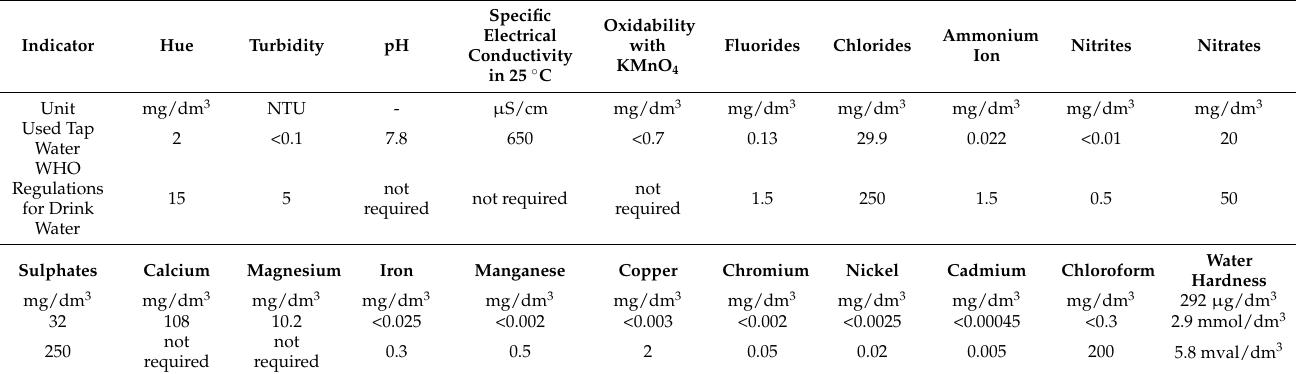
Table 1. Compositions of used tap water [69].